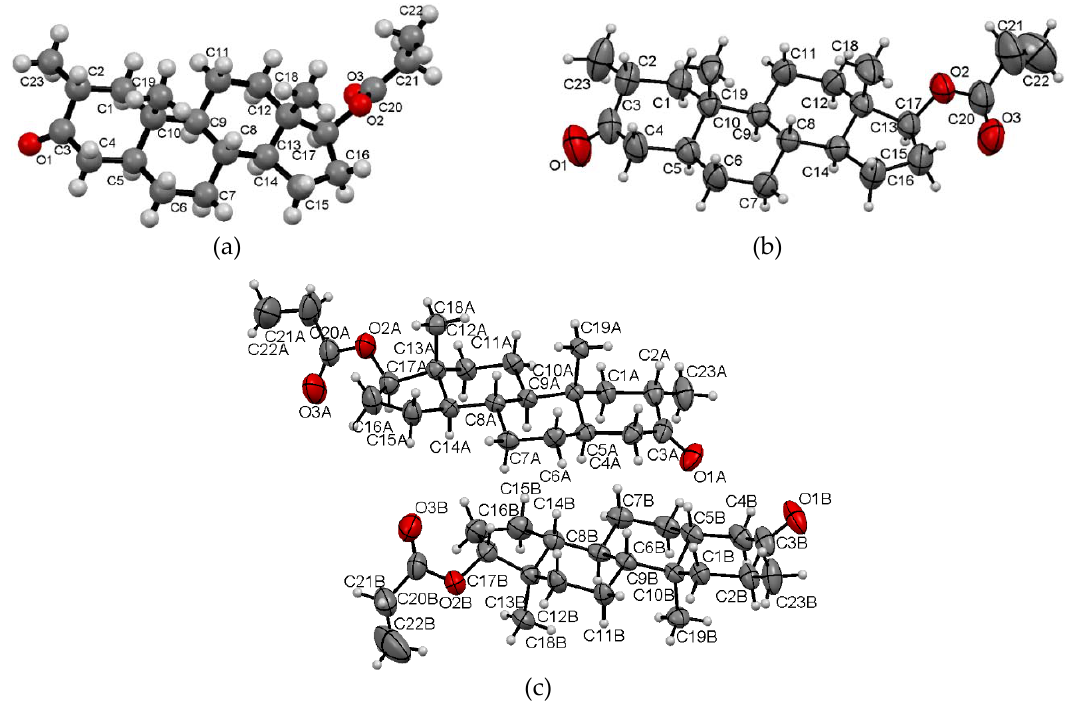
Figure 2. Molecular configuration of the asymmetric units for Drost 1 ( a ), Drost 2 ( b ), and Drost 3 ( c ). Drost 2 displays the thermal ellipsoids at 50% probability and Drost 3 at 30% probability level. Table 1. Single crystal X-ray experimental details.